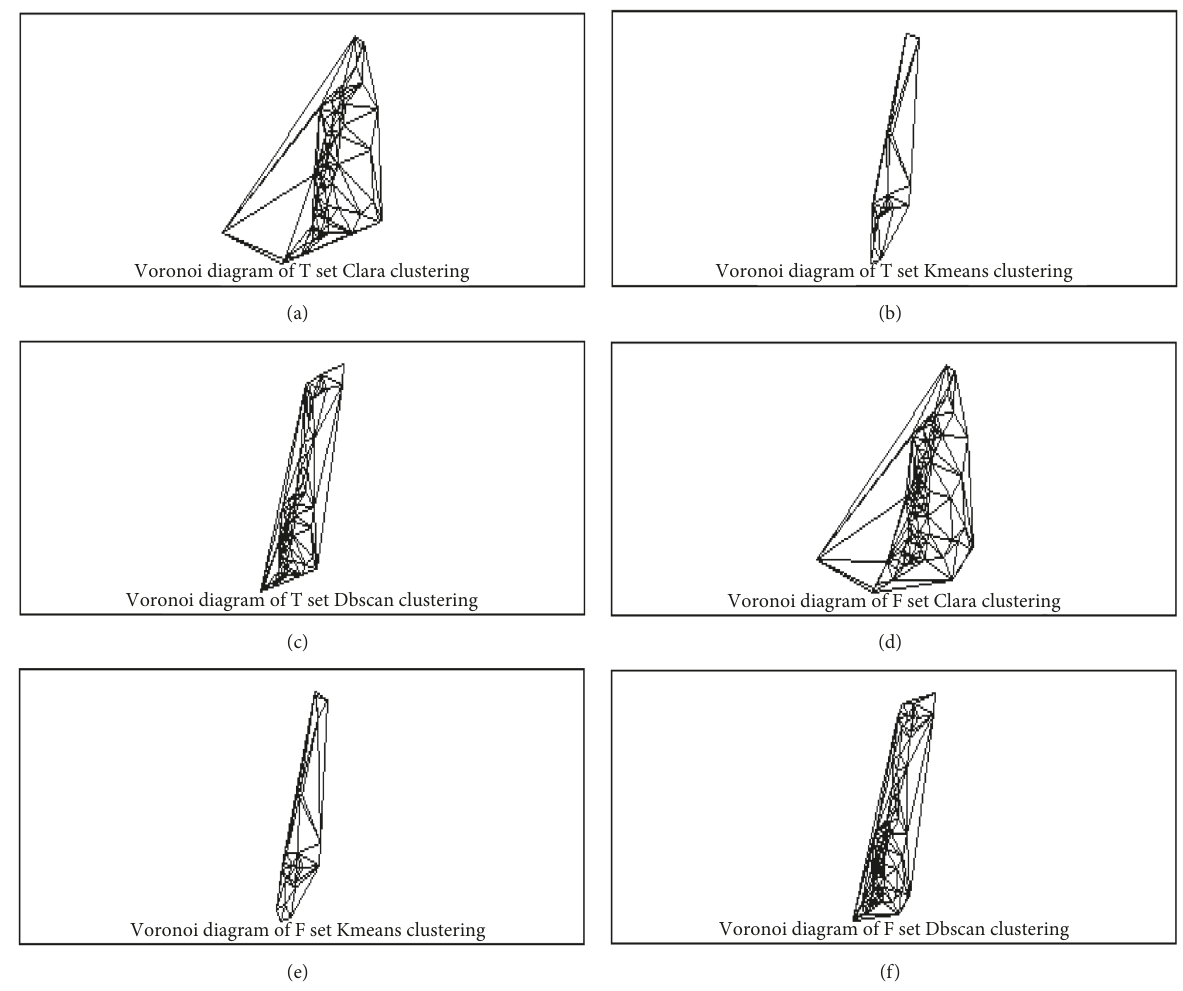
Figure 6: (a) Voronoi diagram of T set clara clustering. (b) Voronoi diagram of T set kmeans clustering. (c) Voronoi diagram of T set dbscan clustering. (d) Voronoi diagram of F set clara clustering; (e) Voronoi diagram of F set kmeans clustering. (f) Voronoi diagram of F set Dbscan